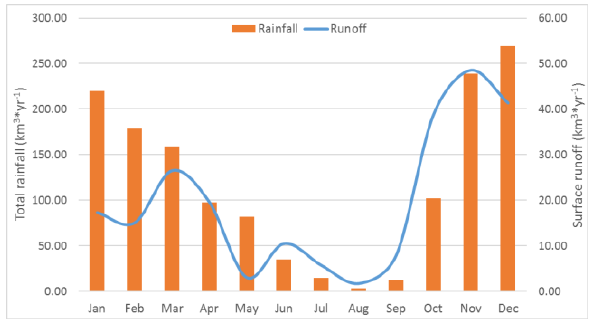
Figure 7. Rainfall- surface runoff simulation for the PESERA